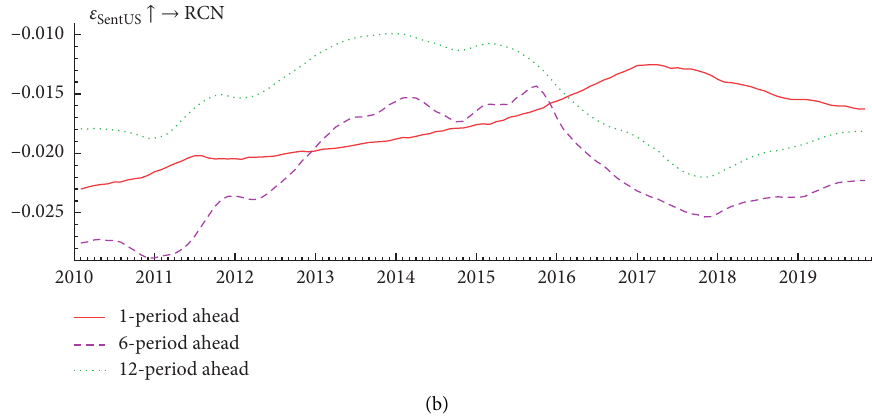
Figure 7: Time-varying impulse responses of the US stock market return.